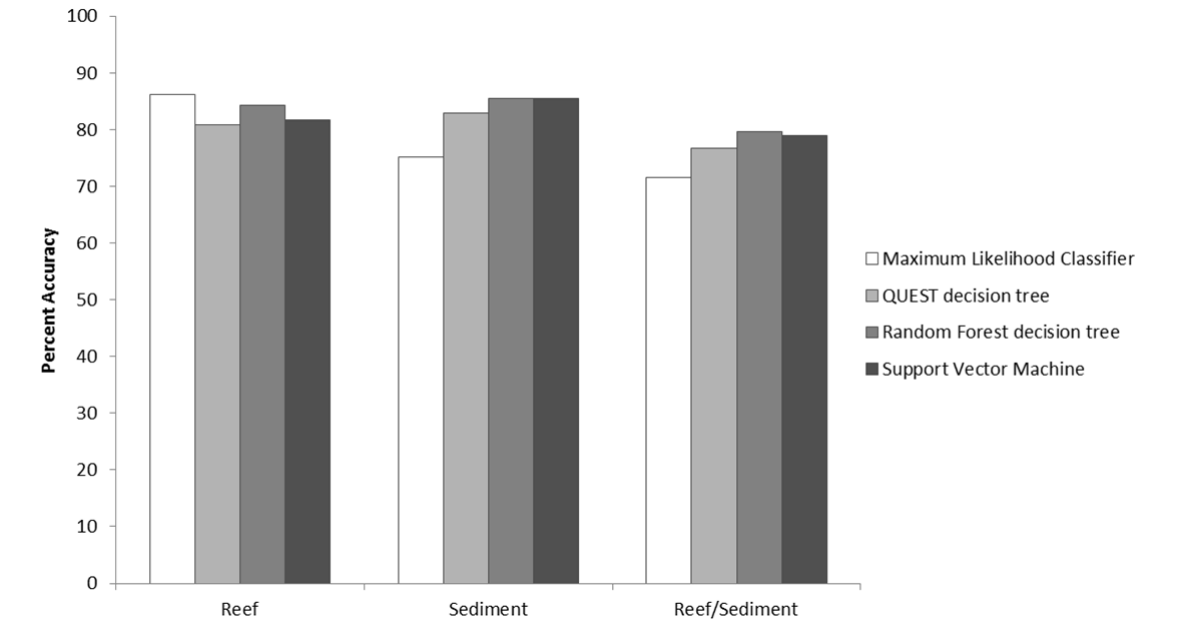
Figure 4. Per class accuracy (mean value between user and producer’s accuracy) for three substratum classes and four different